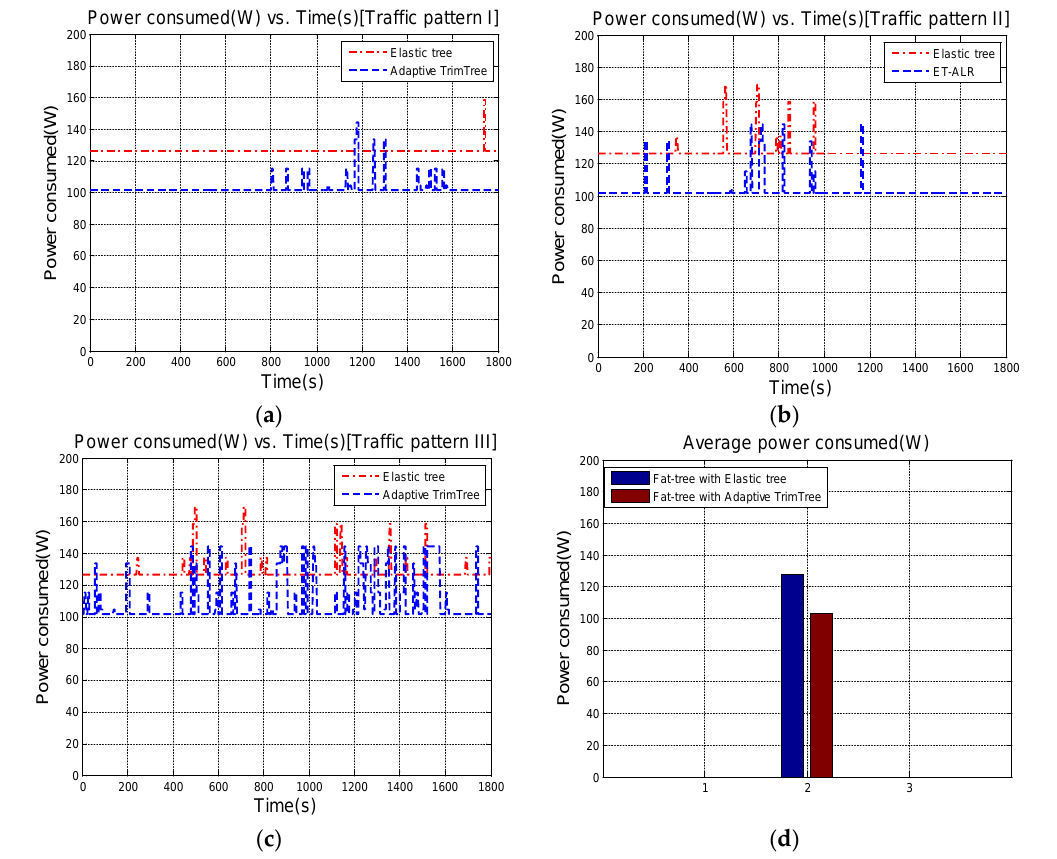
Figure 7. ( a ) Power consumption Adaptive TrimTree vs. ElasticTree for traffic pattern I; ( b ) Power consumption Adaptive TrimTree vs. ElasticTree for traffic pattern II; ( c ) Power consumption Adaptive TrimTree vs. ElasticTree for traffic pattern III; ( d ) Average power consumption Adaptive TrimTree vs. ElasticTree.